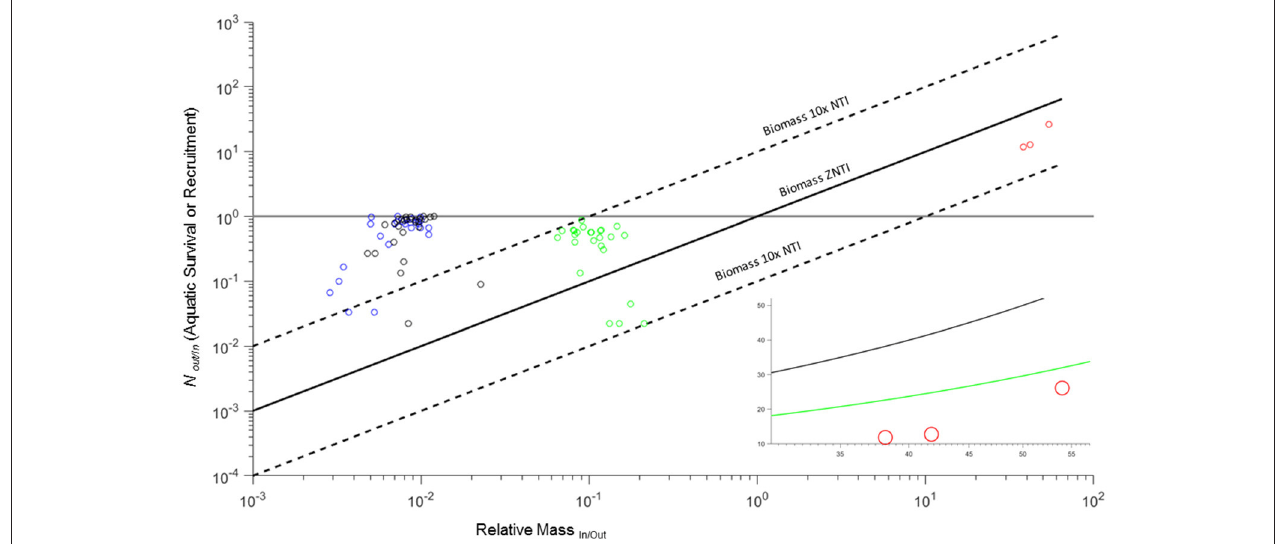
FIGURE 4 | Zero net transfer and 10x net transfer biomass isoclines for RM In / Out and N Out / In for amphibian mesocosms (blue, black, and green: L . sphenocephalus, H. versicolor, and A. americanus ) and Atlantic salmon (red: assuming complete breeding mortality). Horizontal gray line indicates the upper limit of N Out / In for aquatic survival for amphibian larvae (cannot exceed 1). Inset image shows salmon data against the biomass ZNTI (black line) and P ZNTI (green line: derived from average smolt and adult P across three populations).